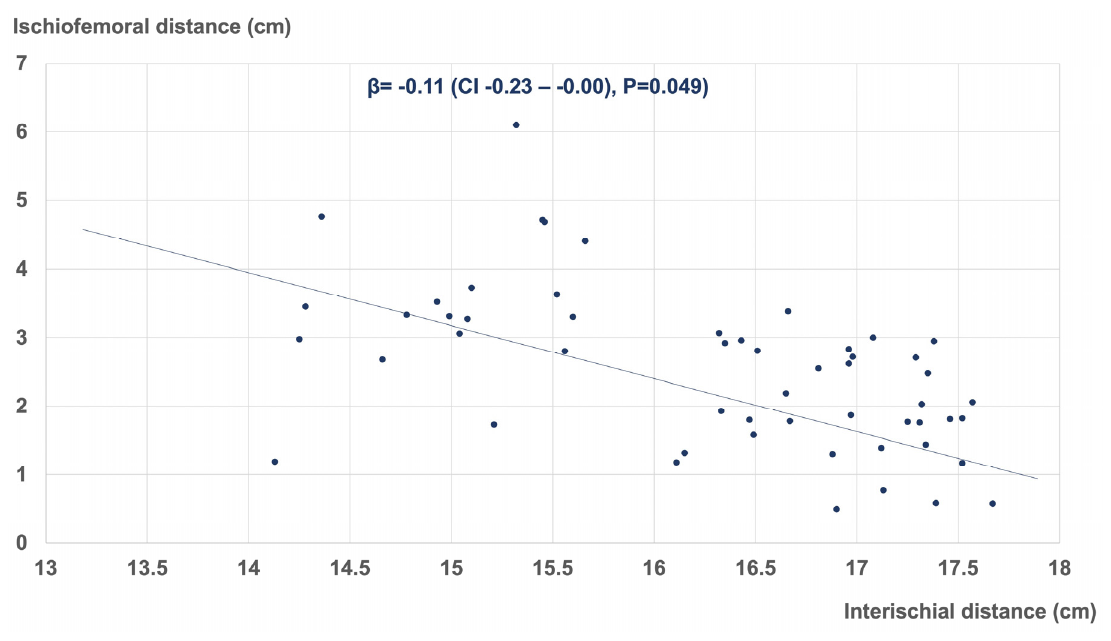
Figure 5. Linear regression demonstrating the association between the pubic-arc angle and the is- chiofemoral distance (R 2 = 0.82).